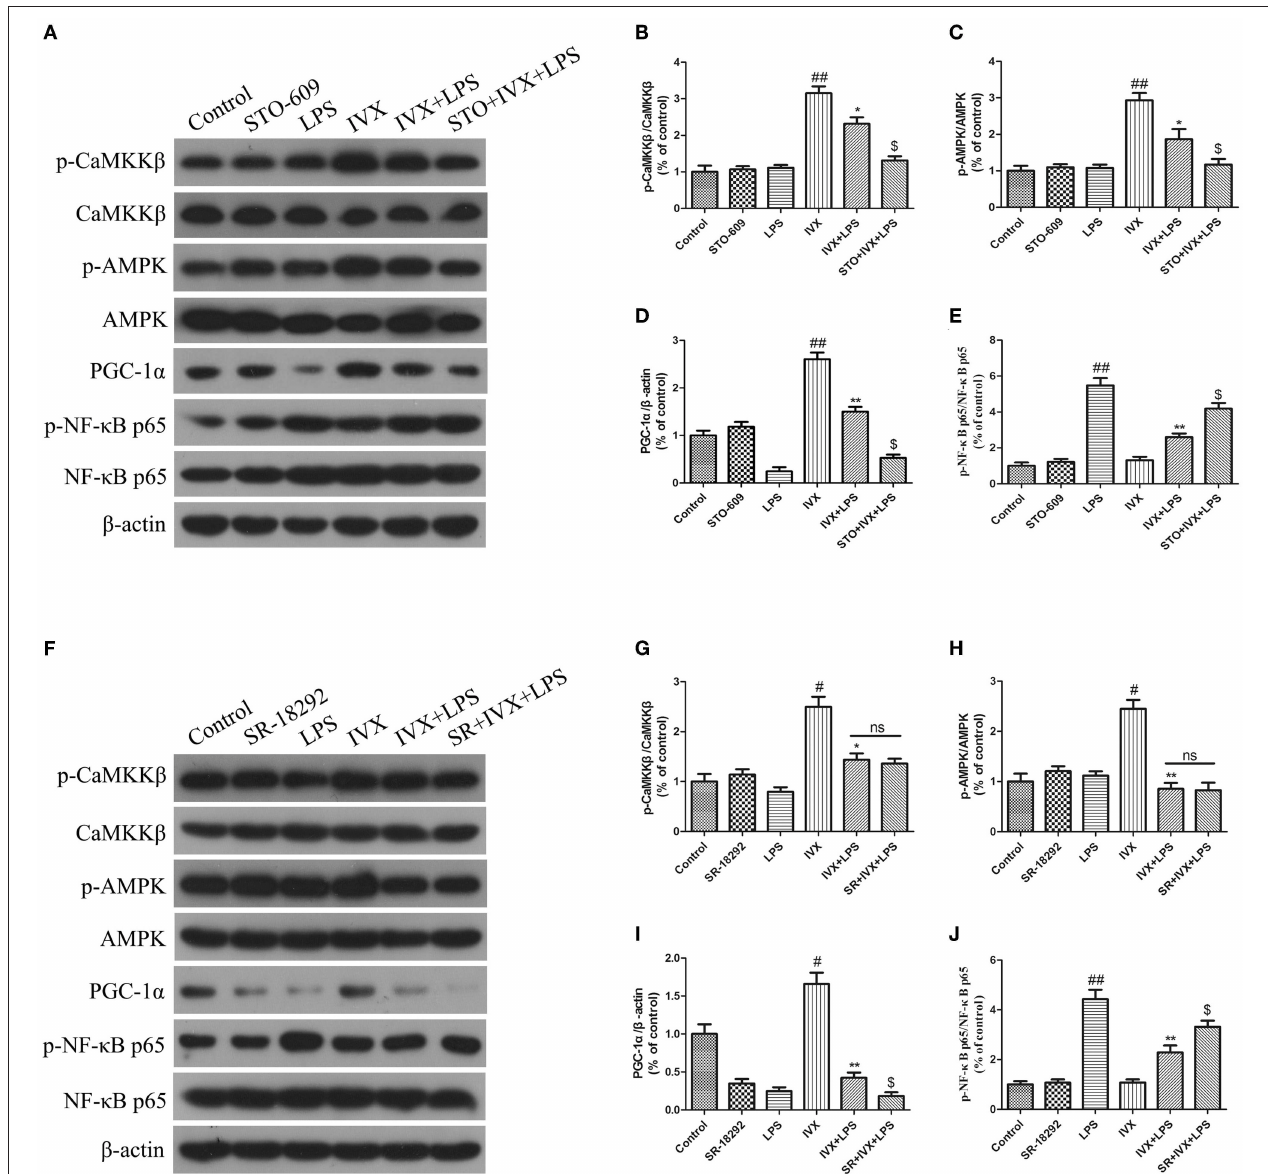
FIGURE 8 | IVX activated the CaMKK β /AMPK-PGC-1 α signaling axis in the cerebral cortices of LPS-injected mice. After the open field test, the cerebral cortices of the mice were harvested. (A–J) The protein expression of p-CaMKK β , p-AMPK, CaMKK β , AMPK, PGC-1 α , NF- κ B p65, and p-NF- κ B p65 in the cerebral cortices of LPS-injected mice were determined by western blotting. The experiments were conducted in triplicate and repeated at least three times. Values are expressed as mean ± SEM ( n = 4–5 in each group). # p < 0.05 and ## p < 0.01, vs. control group; * p < 0.05 and ** p < 0.01 vs. IVX group; $ p < 0.05 vs. IVX + LPS group.